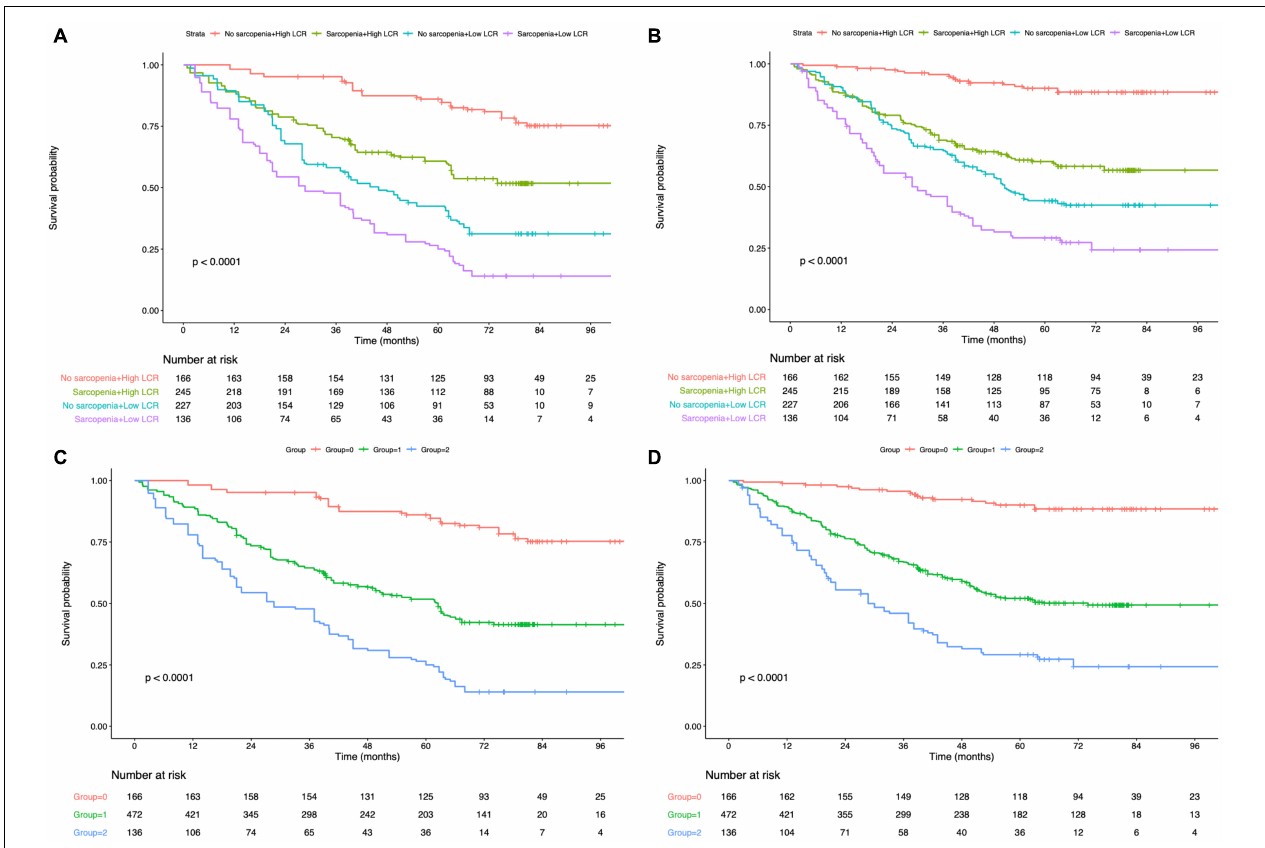
FIGURE 3 | Kaplan–Meier survival analysis of overall survival according to Peking prognostic score (A) and group (C) . Kaplan–Meier survival analysis of disease-free survival according to Peking prognostic score (B) and group (D) . LCR, lymphocyte-to-C-reactive protein ratio.